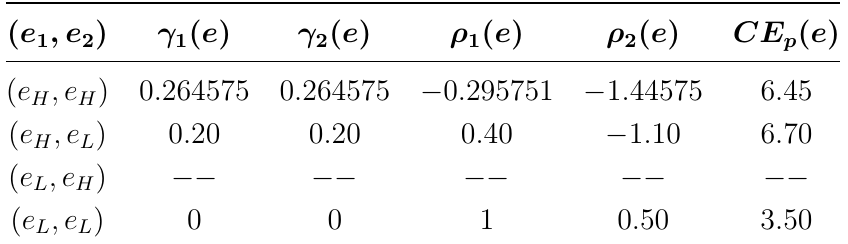
Table 2. Optimal incentive contracts of Example